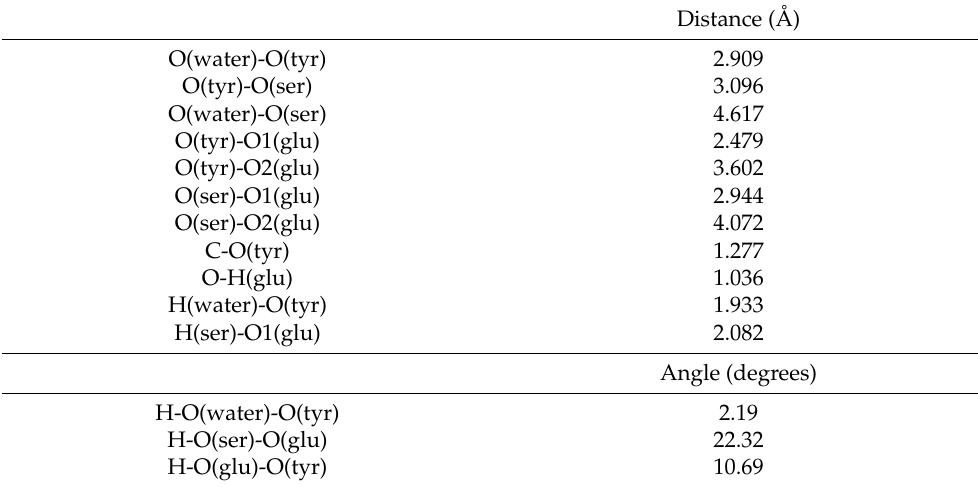
Table 2. Structural parameters (distances (Å) and angles (degrees)) of psamFP488 optimized starting from the second HB network compatible with the experimental